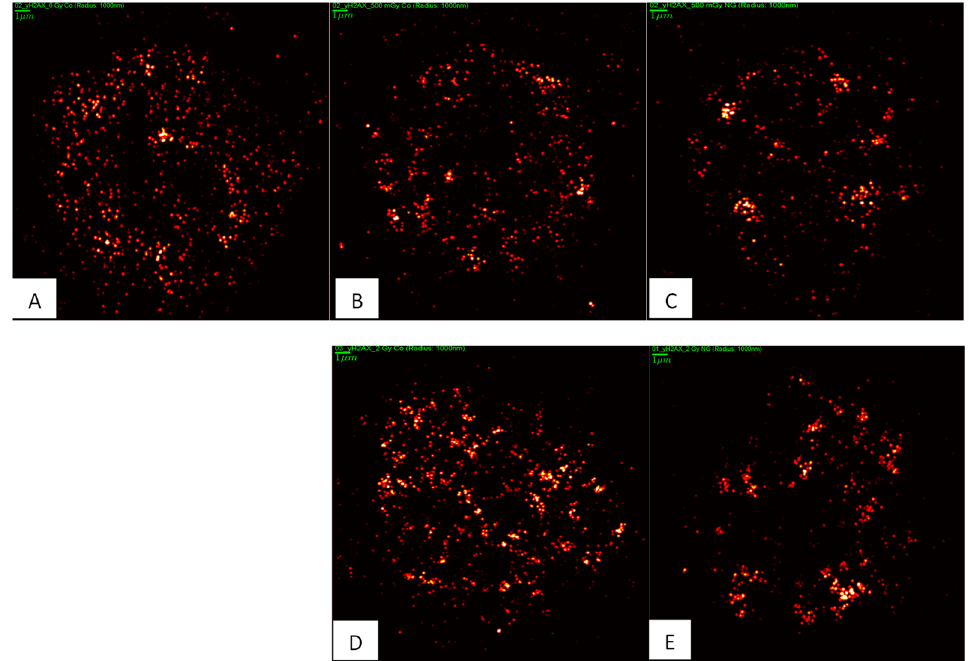
Figure 7. Illustrative SMLM next-neighbor density images comparing γ H2AX labelling tag numbers and distributions in SkBr3 cells after irradiation ( B , D ) without particle incubation and after irradiation preceded by uptake of 10 nm Au-NPs into the cytosol ( C , E ). The intensity of the points represents the number of next neighbors in a 1000 nm radius environment. The control without any treatment (no NP-incubation, and no irradiation) is shown in ( A ), indicating some repair activity also in untreated cells. Images of irradiated cell were taken at 45 min PI. Scale bar: 1 µm.